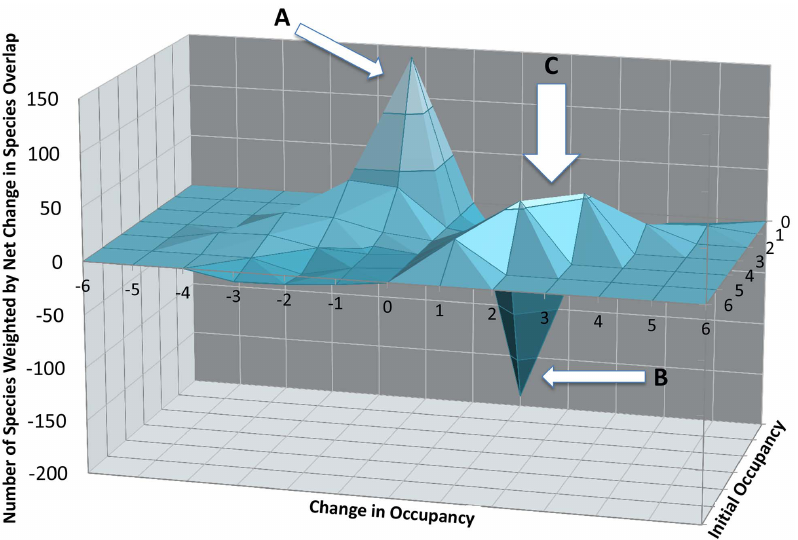
Figure 5. Effects of occupancy changes on b -Diversity. Net effect of occupancy change between historical and modern time intervals. The peaks represent species (A) at one site that disappeared, (B) appearing at one site and (C) originally at 2–5 sites that increased their occupancies. Peaks A and B show predicted rare mammal turnover [43–44], which effectively cancel each other out. Peak C includes species across all body size classes and drives the pattern of increasing similarity from historical to modern